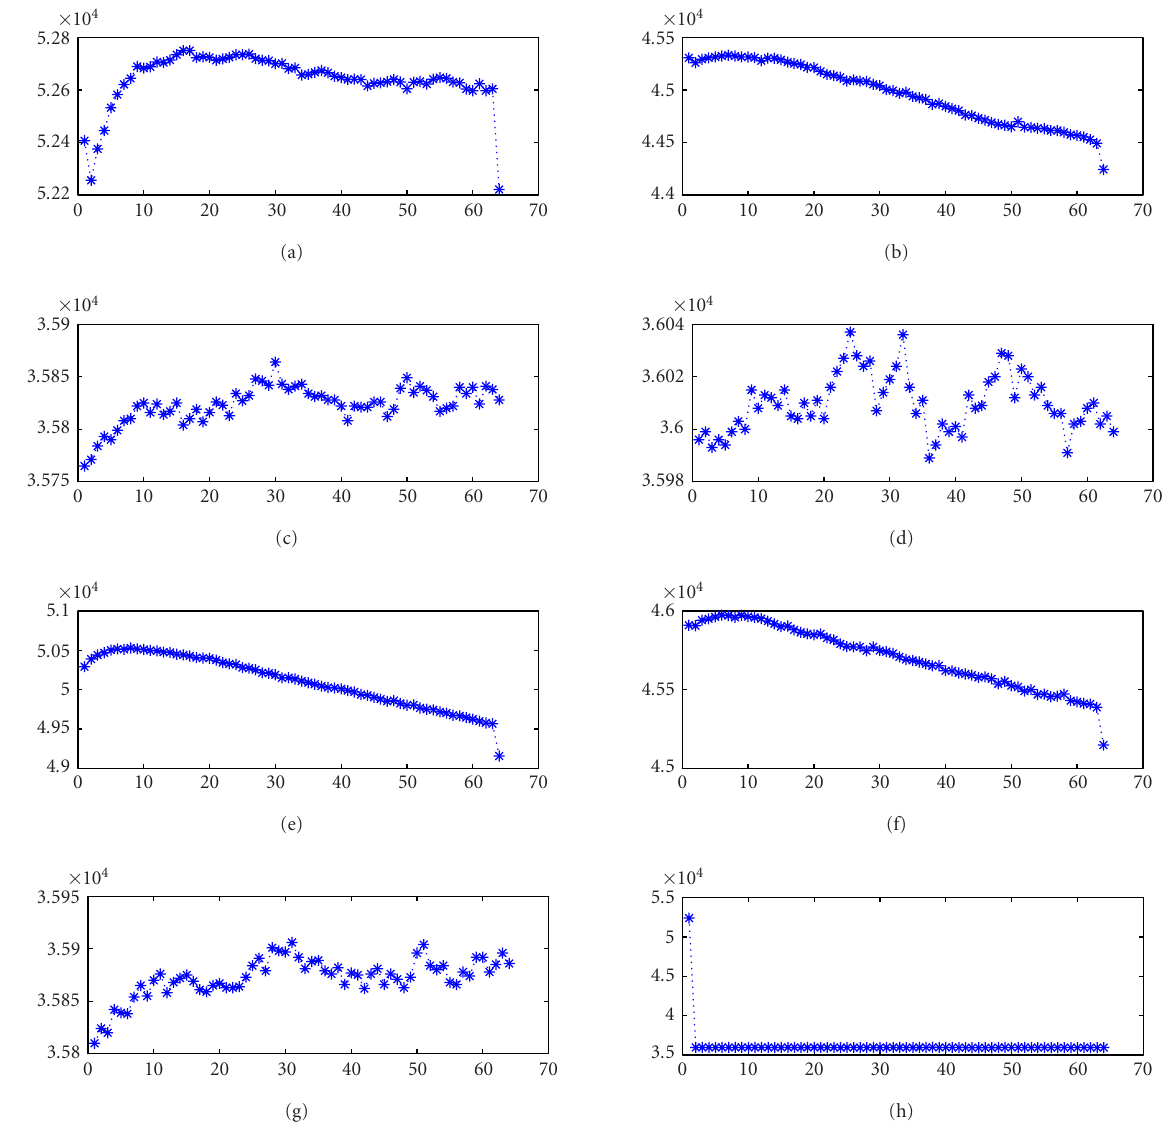
Figure 2: Example of di ff erent 1D infrared signals for eight selected PACS photoconductors data: (a) active detector 1, (b) active detector 3, (c) blind detector 17, (d) blind detector 18, (e) active detector 18, (f) active detector 5, (g) blind detector 1, and (h) blind detector 2.